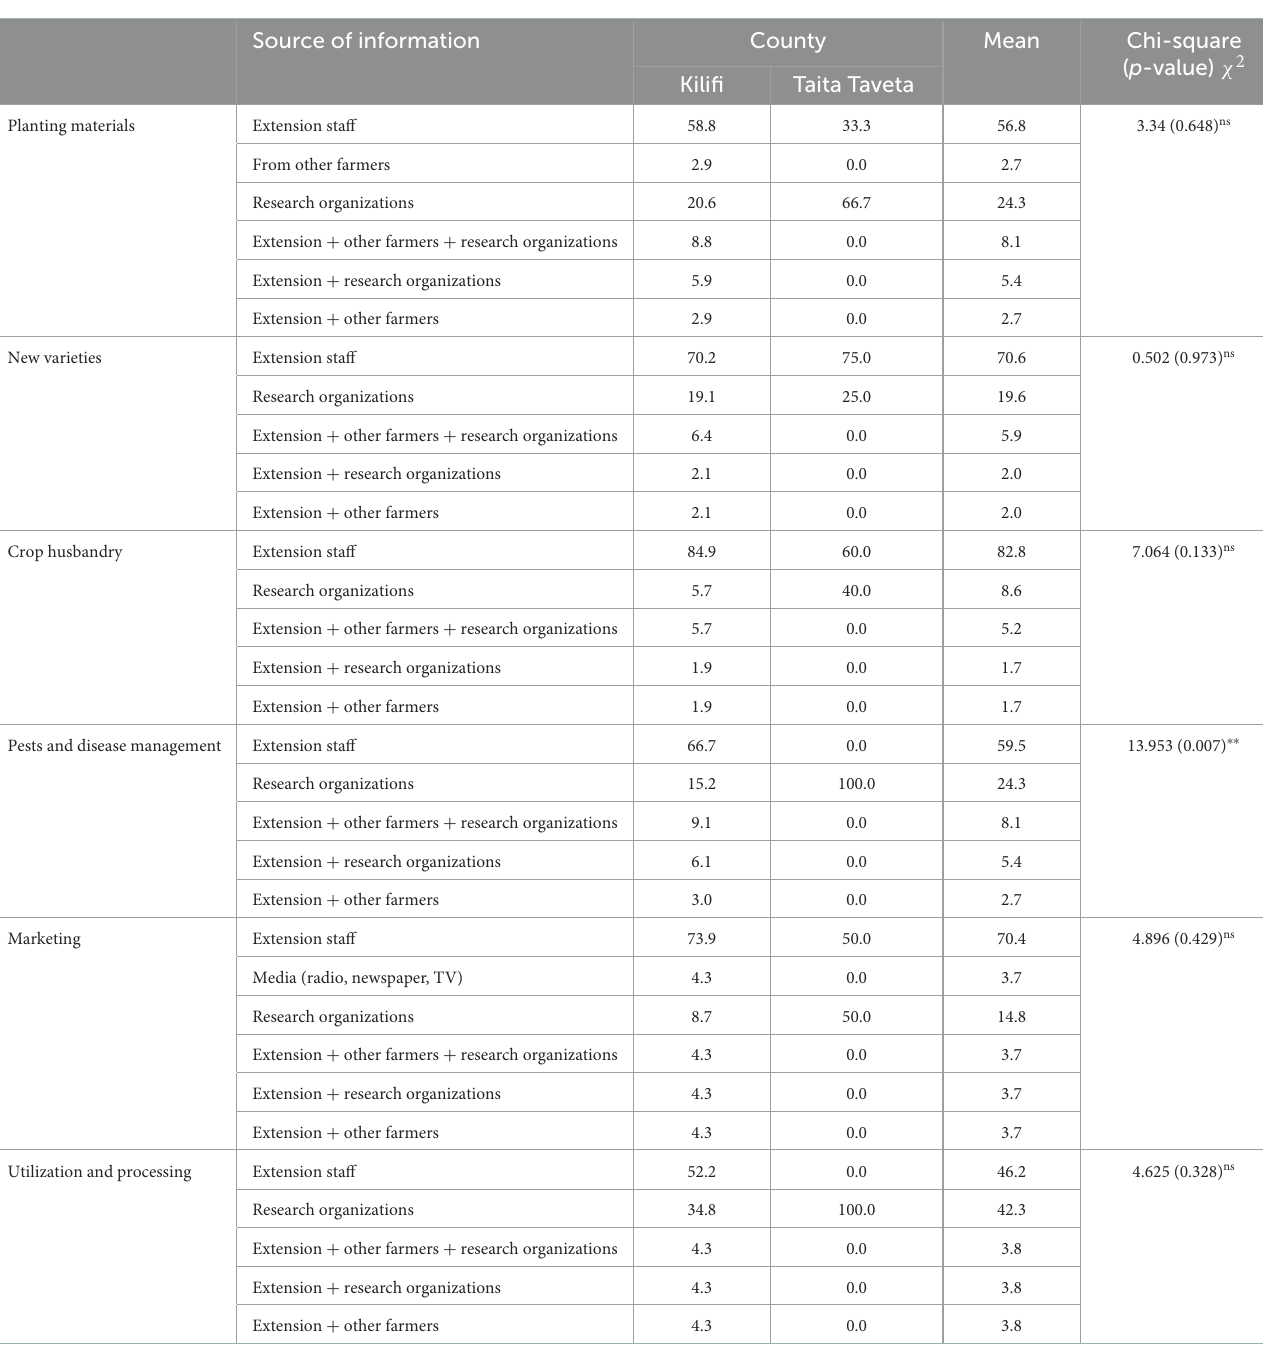
TABLE 3 Sources of information on cassava